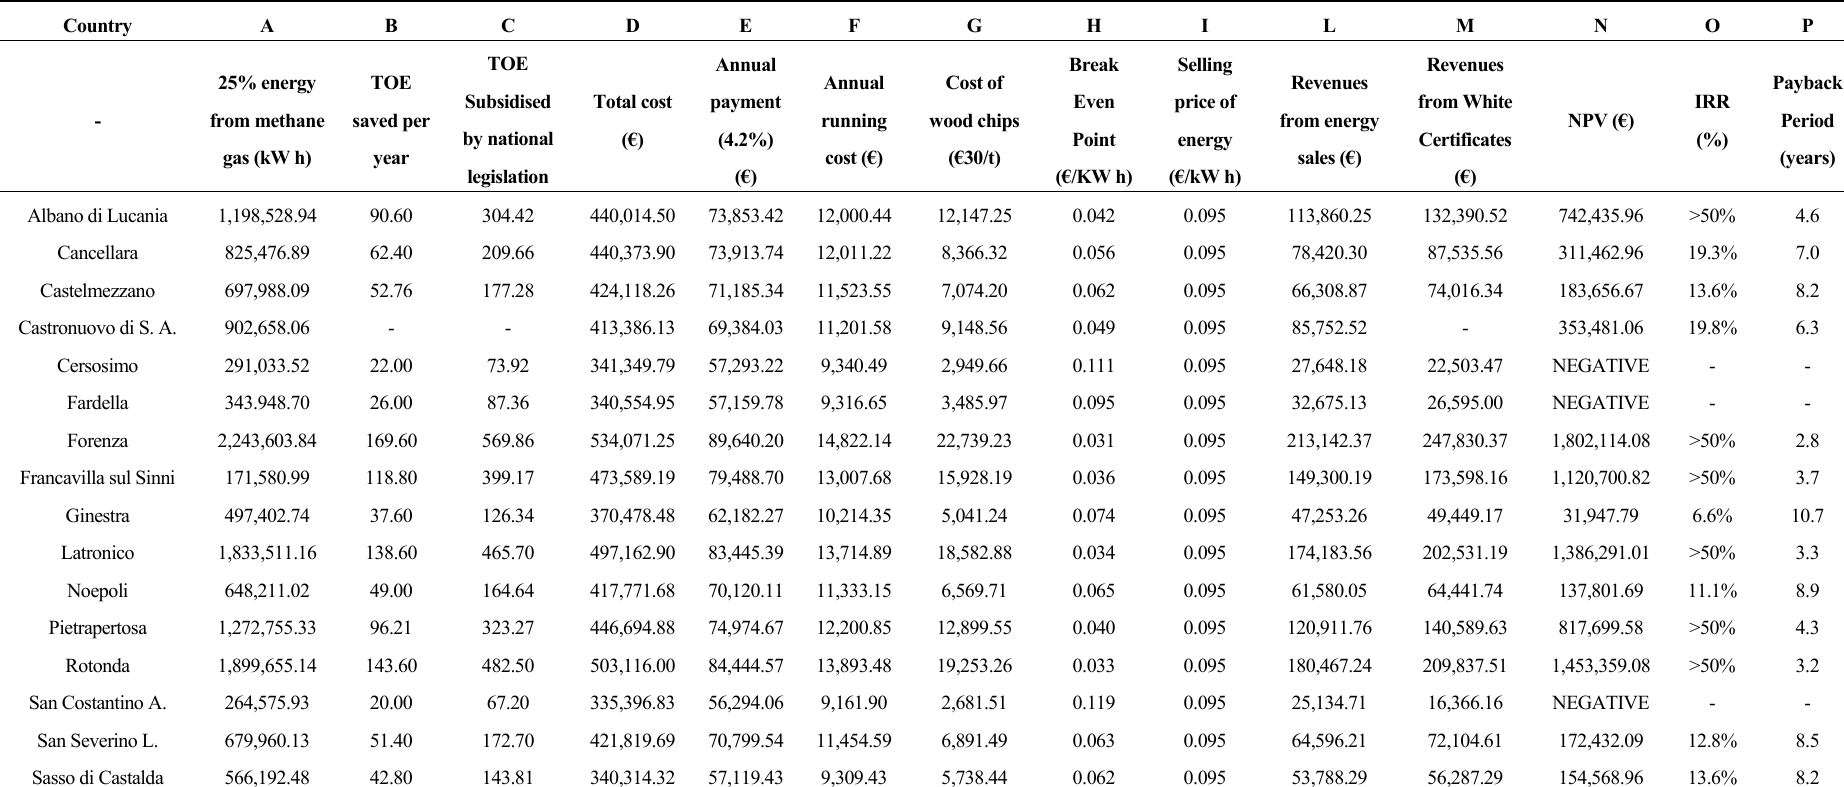
Table 10. Table summarizing the economic evaluation of facility investments. Source: Elaboration of the